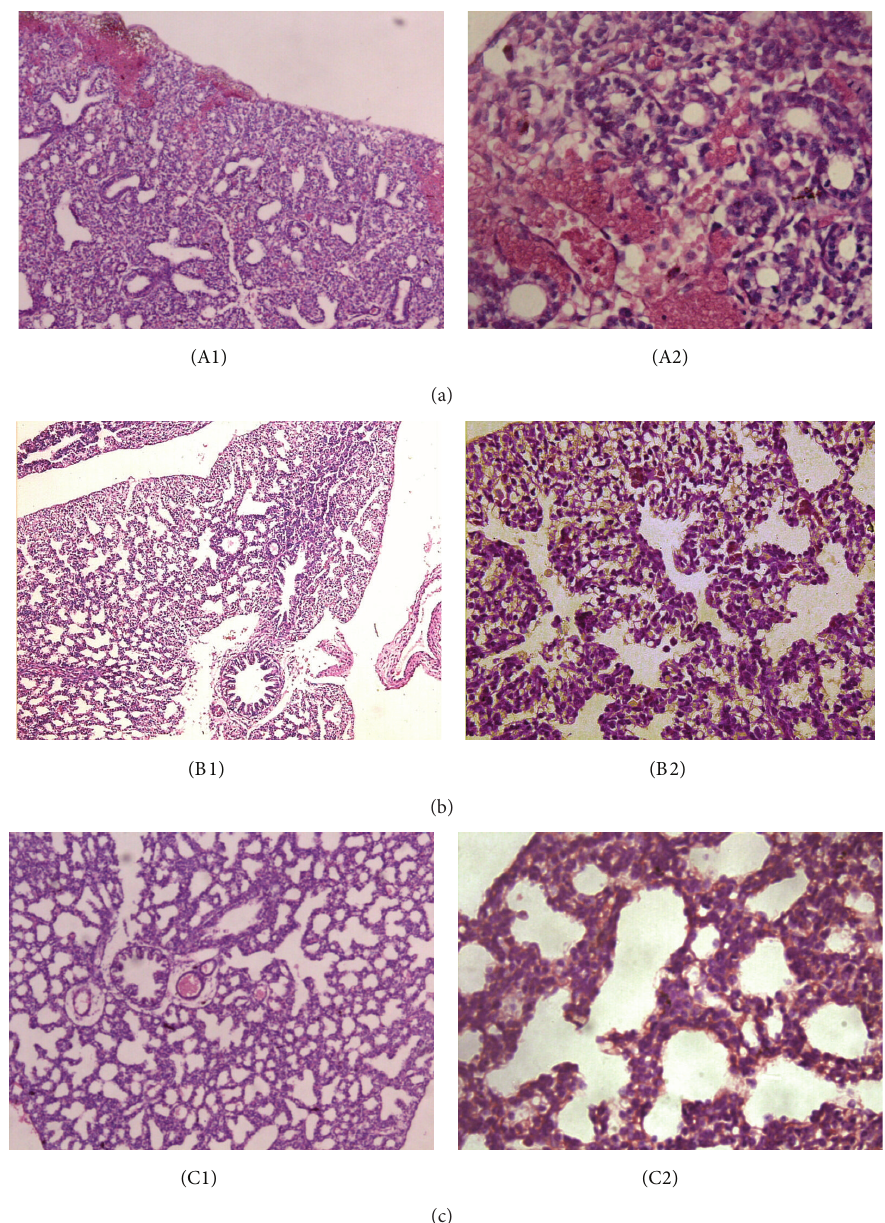
Figure 1: The morphology of fetal rat lungs in light microscope. (a) The high bile acid group: immature fetal lung tissue with smaller alveolar space, thicker alveolar septal, and a large number of hemorrhagic lesions were observed. HE: × 100 (A1), × 400 (A2). (b) The low bile acid group: fetal lung tissue with small alveolar space and thick alveolar septal were observed. HE: × 100 (B1), × 400 (B2). (c) The experimental control group: mature fetal lung tissue with large alveolar space and thin alveolar septal were observed. Alveolar epithelial cells, cytoplasm stained (red), and nuclear (flat). HE: × 100 (C1), × 400